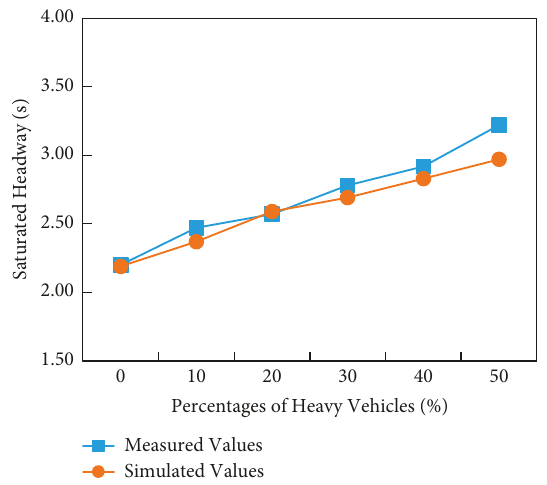
Figure 23: Comparison of simulated and measured values of saturation headway in different percentages of heavy vehicles